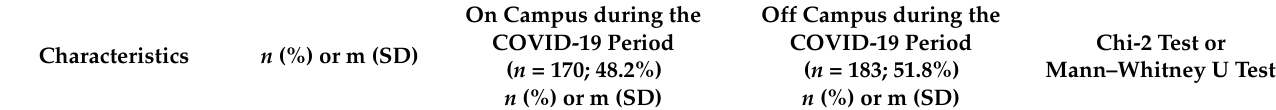
Table 1. Sociodemographic and academic characteristics of the sample ( n =